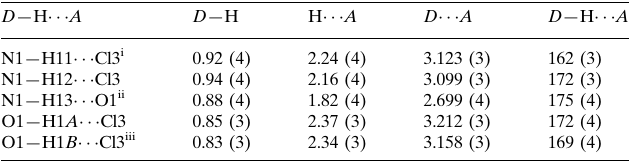
Hydrogen-bond geometry (A˚ , (cid:3)